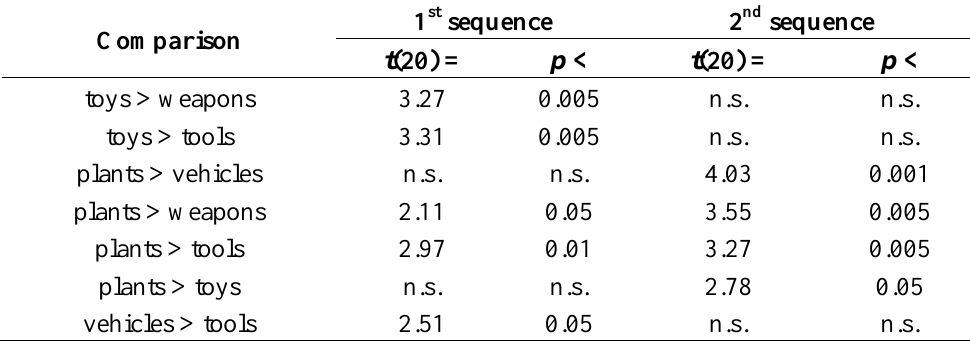
Table 5. Within category comparison for